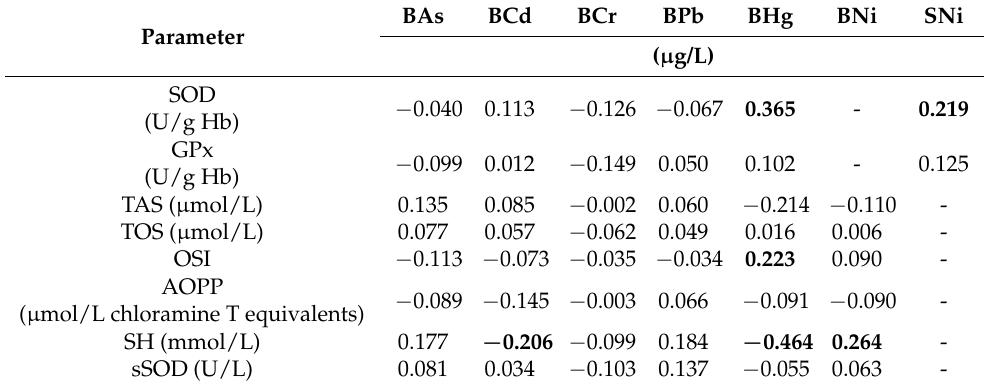
Table 3. Spearman’s correlation coefficients for the relationship between the parameters of oxidative stress and the concentrations of the measured metal(loid)s in men with prostate cancer and controls.